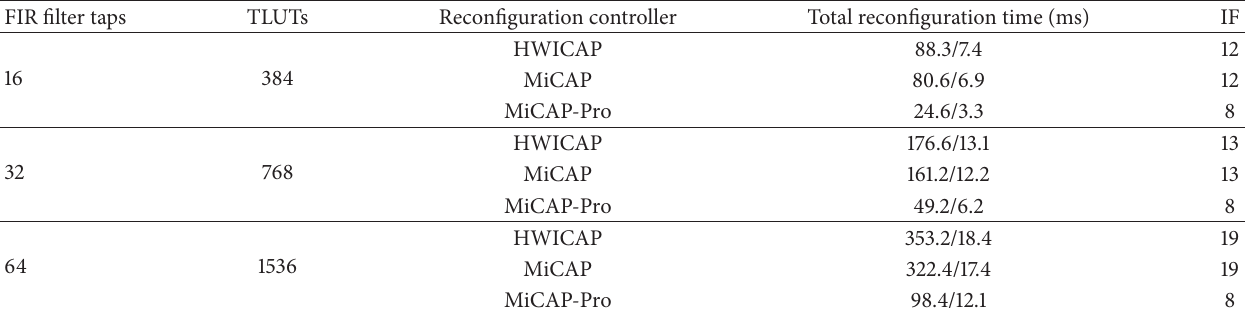
Table 6: Total reconfiguration time without placement constraints.